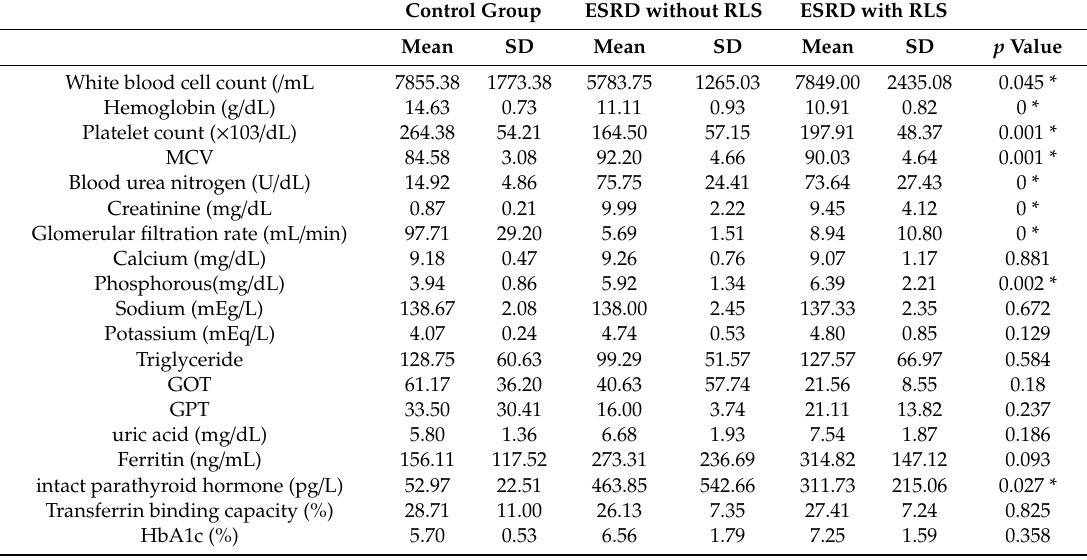
Table 2. Hematologic and biochemical results of the three groups. MCV: mean corpuscular volume; GOT: glutamic oxaloacetic transaminase; GPT: glutamic pyruvic transaminase; HbA1c: Glycosylated hemoglobin, type